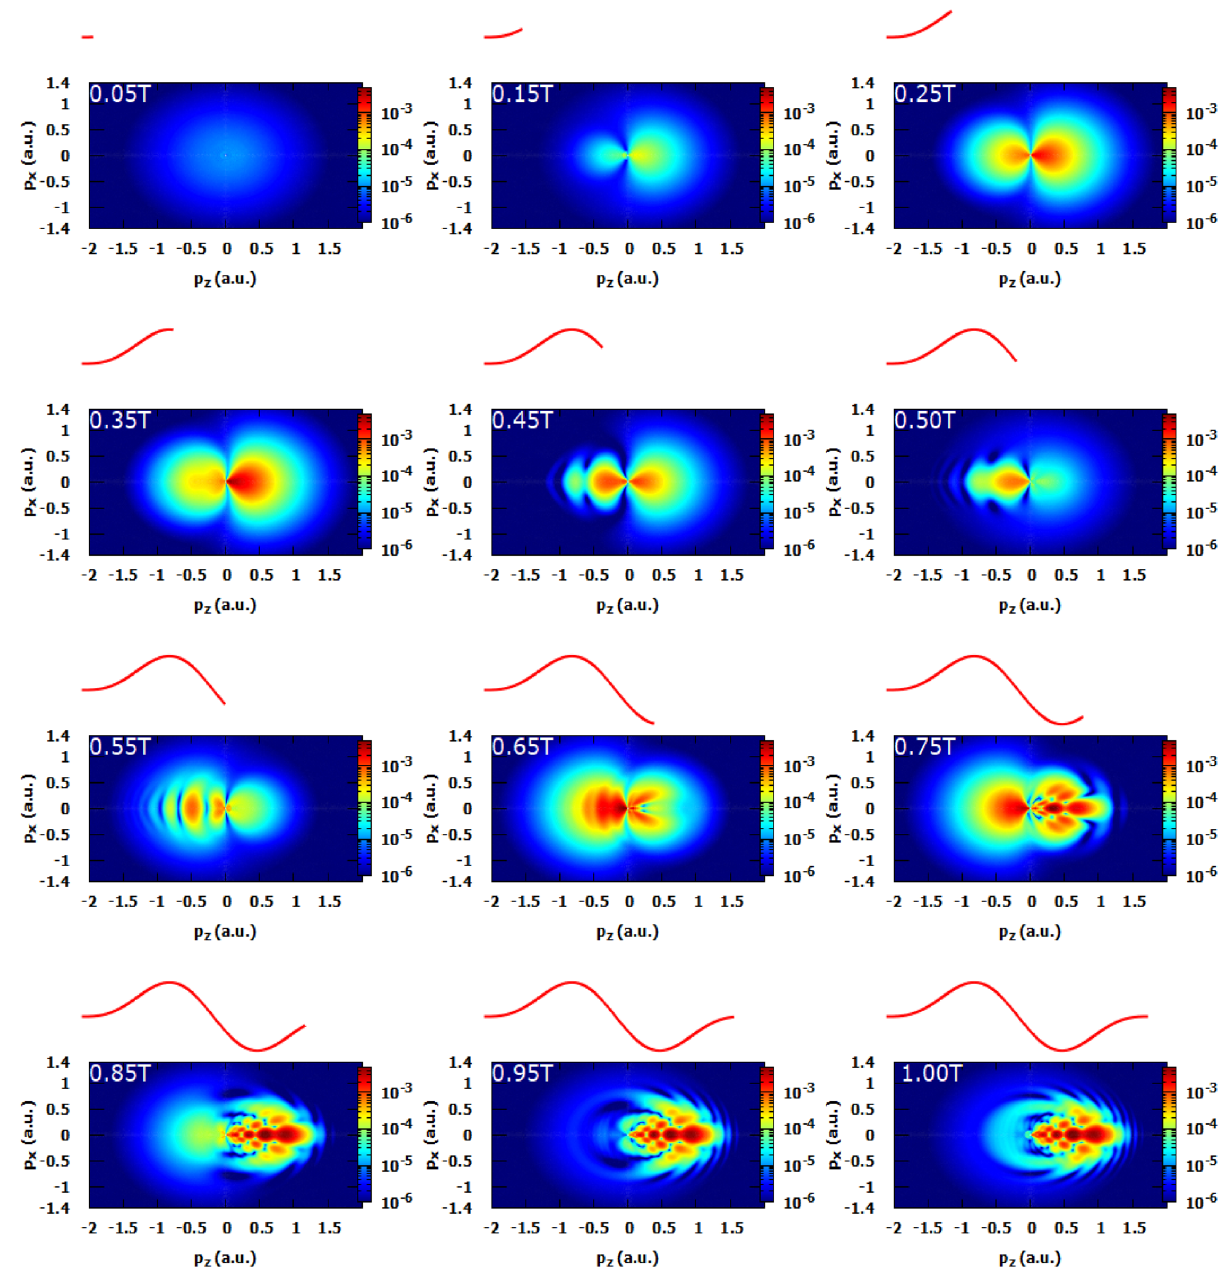
Figure 3. Snapshots of the photoelectron momentum distribution in case of a single-cycle pulse. The laser parameters are set as in Fig. 2. The red curve represents the electric field as a function of time. All the heat maps in this figure were generated using Gnuplot software (www. gnupl ot. info), version [5.4] for Unix Figure 5 shows the PMDs calculated for different optical cycles namely for N = 1–3,8 at peak intensity of 1 × 10 14 W / cm 2 . The cases of one and two cycle pulses (panel (a) and (b)) we already discussed. The PMD associ- ated to the three-cycle pulse ( N = 3 ) (panel (c) of Fig. 5) shows a modulated spider-like structure in the backward direction and a fish-bone like structure in the forward direction. Moreover, the fan-like structure appears near to the threshold ionization which is due to the joint influence of the electric field and the Coulomb potential on the released electrons 20 . We note that, for single cycle, two cycle and three cycle pulse the obtained PMDs are not symmetrical. The fan-like structure is clearly formed for the case of multi-cycle pulses. The holographic structure can be identified from N = 3 and for large N. In Fig. 5 the panel (d) presents the PMD for an eight cycle pulse where the fan-like structure appears clearly at low photoelectron energies. In addition, the spider legs structure are also present for this multi-cycle pulse where the fish-bone like structure cannot be identified clearly due to the presence of the ATI rings. Subsequently, we can conclude that it is more relevant to use few-cycle pulses in case of holographic investigations. The formation